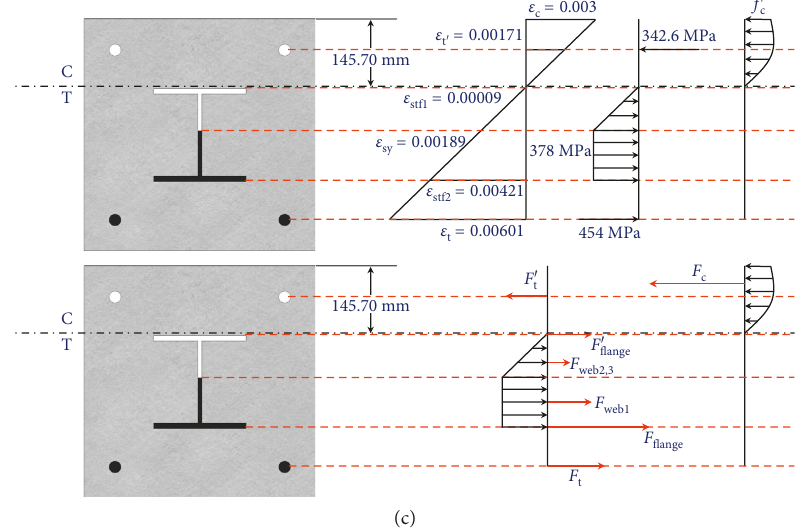
Figure 5: Strain and stress distribution of the specimens [19]. (a) Strain and stress state at the maximum load limit state of Specimen #1 (M-